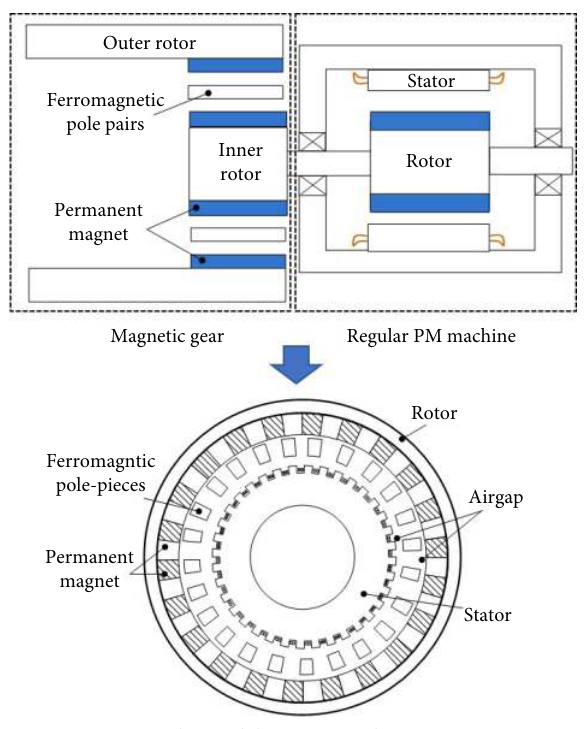
Fig. 13 Topology transforming of FMPMM.